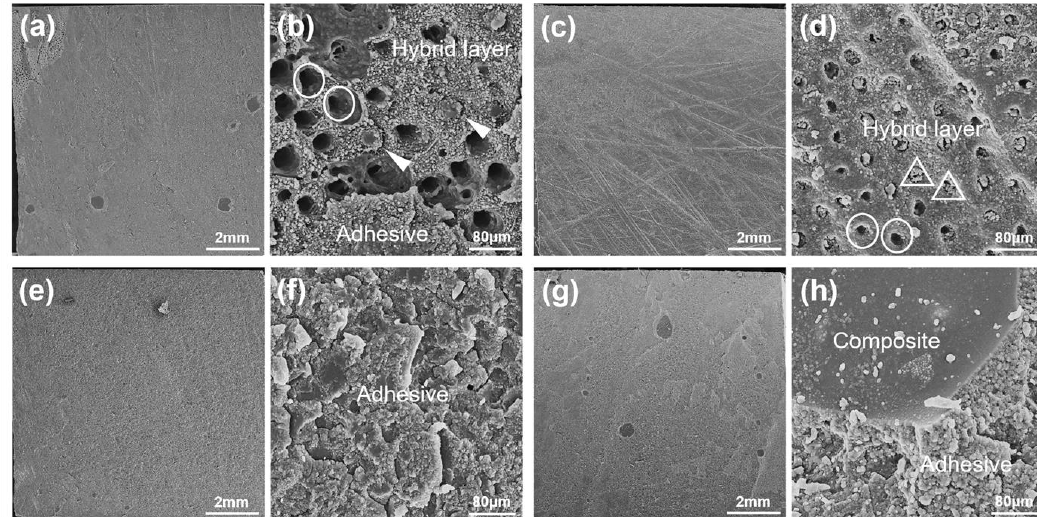
Figure 3 . General condition graphs (×90) and micrographs (×2000) of adhesive and mixed failure on dentin interfaces. ( a , b ) Mixed failure from control group bonded with etch-and-rinse mode; ( c , d ) adhesive failure from desensitizing groups bonded with self-etch mode; ( e , f ) typical adhesive failure; and ( g , h ) typical mixed failure. Circle: open dentin tubules; triangle: sealed dentin tubules; and solid arrowhead: resin tags.